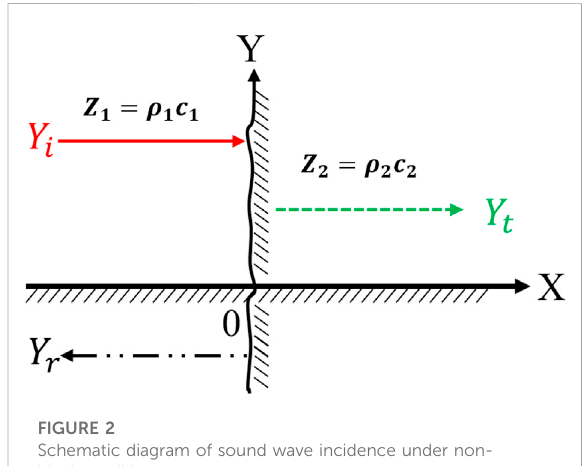
FIGURE 2 Schematic diagram of sound wave incidence under non- ideal